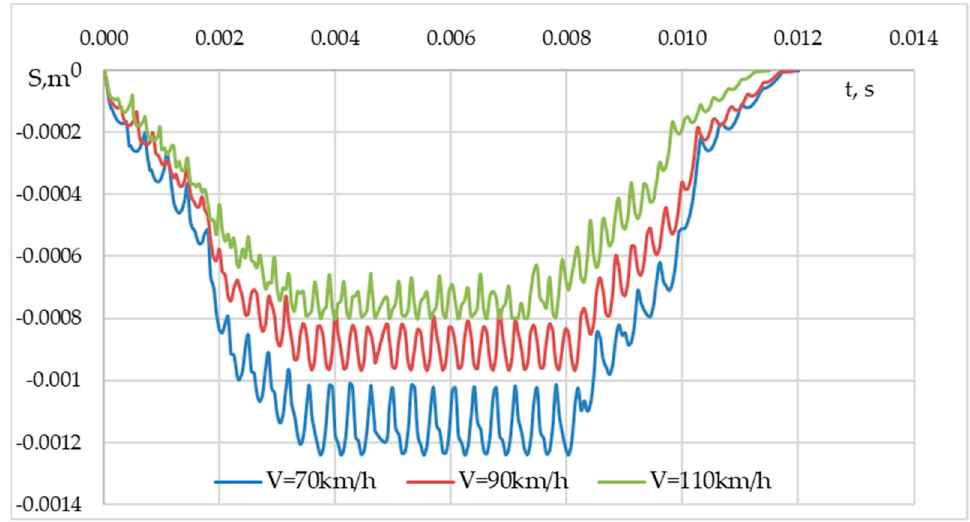
Figure 4. Oscillation amplitudes of the track structure cross-section under the wheel passage over time.